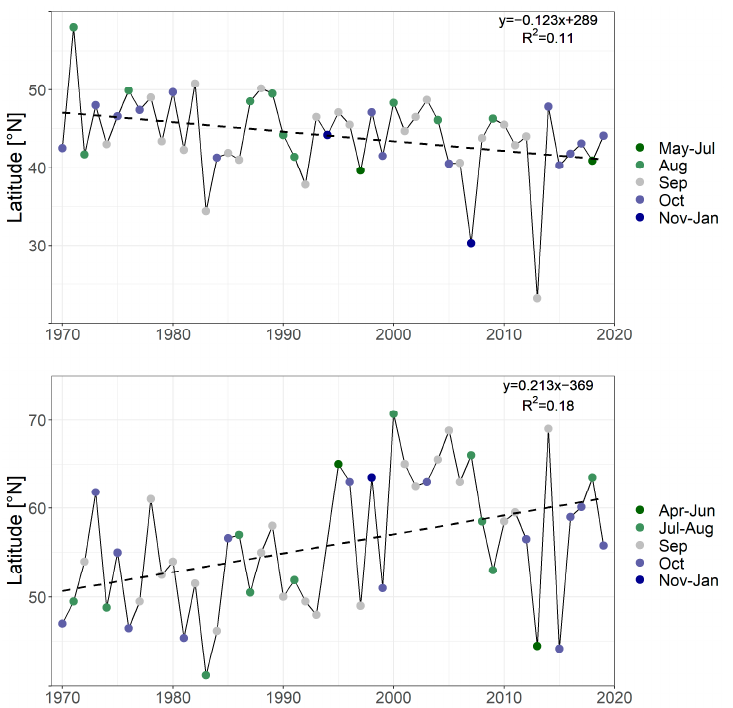
Figure 3. Multiannual changes in the maximum latitude reached in a given year by a TC ( top graph) and an ETC ( bottom graph) of the furthest northern extent in the North Atlantic for the 1970–2019 period, with months taken into account.